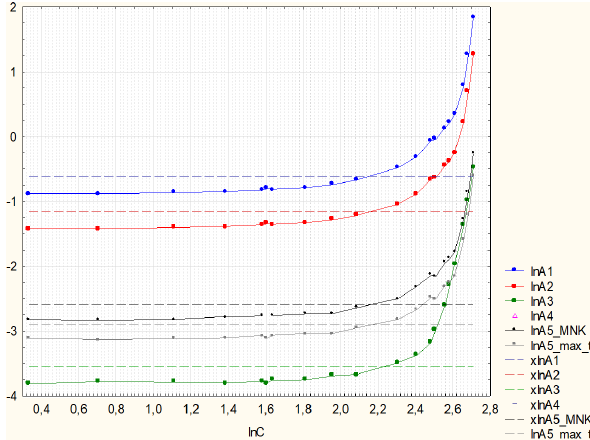
Figure 15. Recognition of 9.1 mg/m 3 NO in artificial air (ZnO-based sensor).